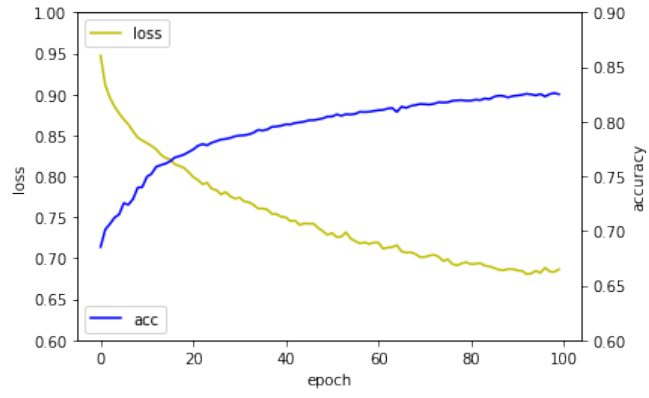
Figure 3. The core part of the VGG 16 model.